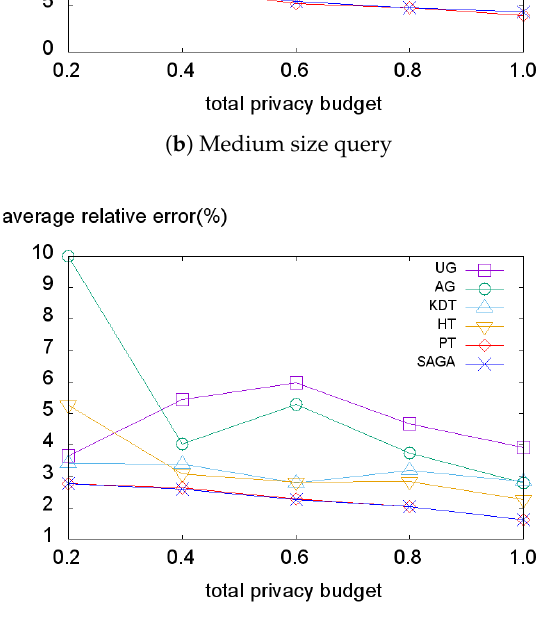
Figure 11. Average relative error on the Gowalla